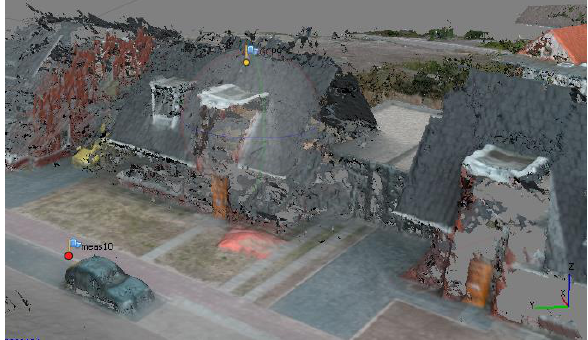
Figure 12: Artefacts in the 3D correlation